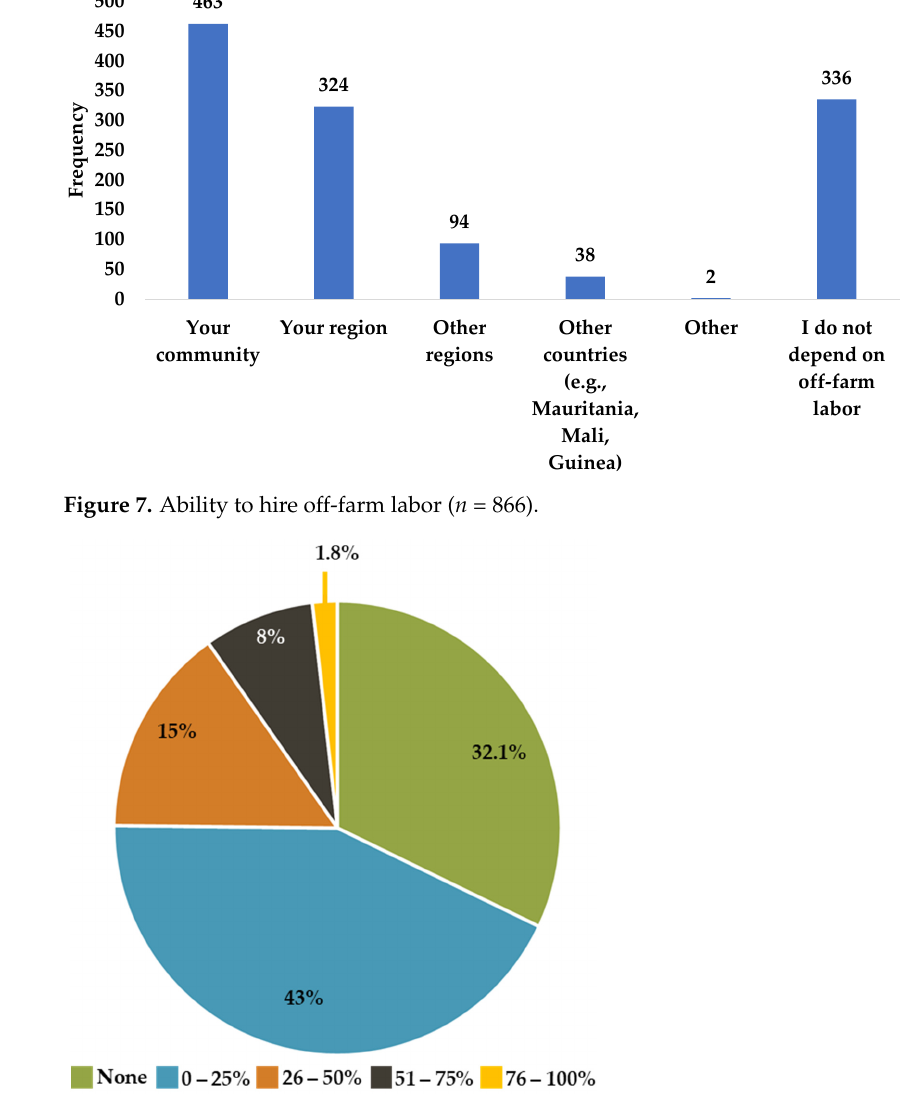
Figure 8. Reduction in labor accessibility.